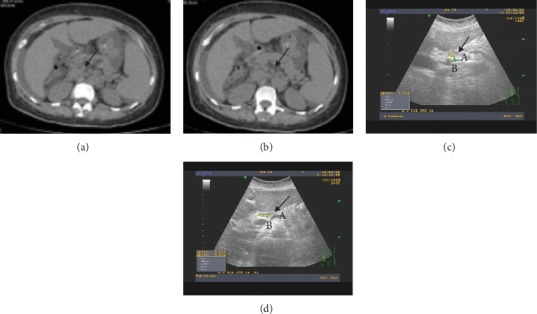
Enlarged lymph node (LN) was detected in autoimmune liver disease (AILD). (a) Abdominal CT examination indicated the enlargement of para-aortic lymph nodes. (b) Abdominal CT examination showed the enlargement of pancreatic lymph nodes. (c) Abdominal ultrasonography showed round enlarged lymph nodes around the pancreas. (d) Abdominal ultrasonography revealed oval enlarged lymph nodes around the pancreas. Abdominal lymph nodes larger than 5 mm but at their shortest diameter were counted. The arrow points to the lymph node: (A) longest axis and (B) perpendicular axis.